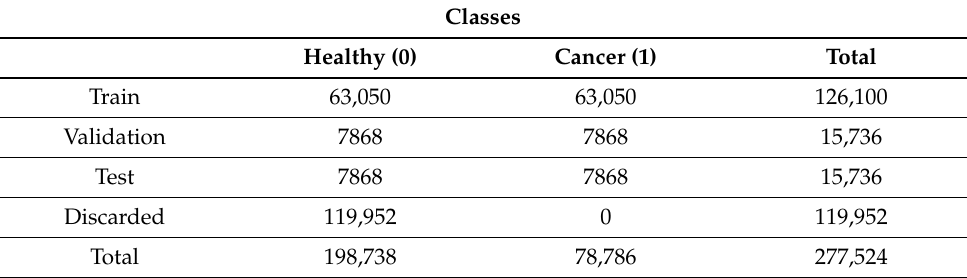
Table 1. Information about the number of breast cancer patches for each data